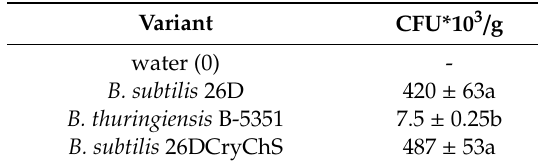
Table 1. Content of Bacillus sp. in plant tissues after surface sterilization, CFU*10 3 / g of plant wet mass (14th day post